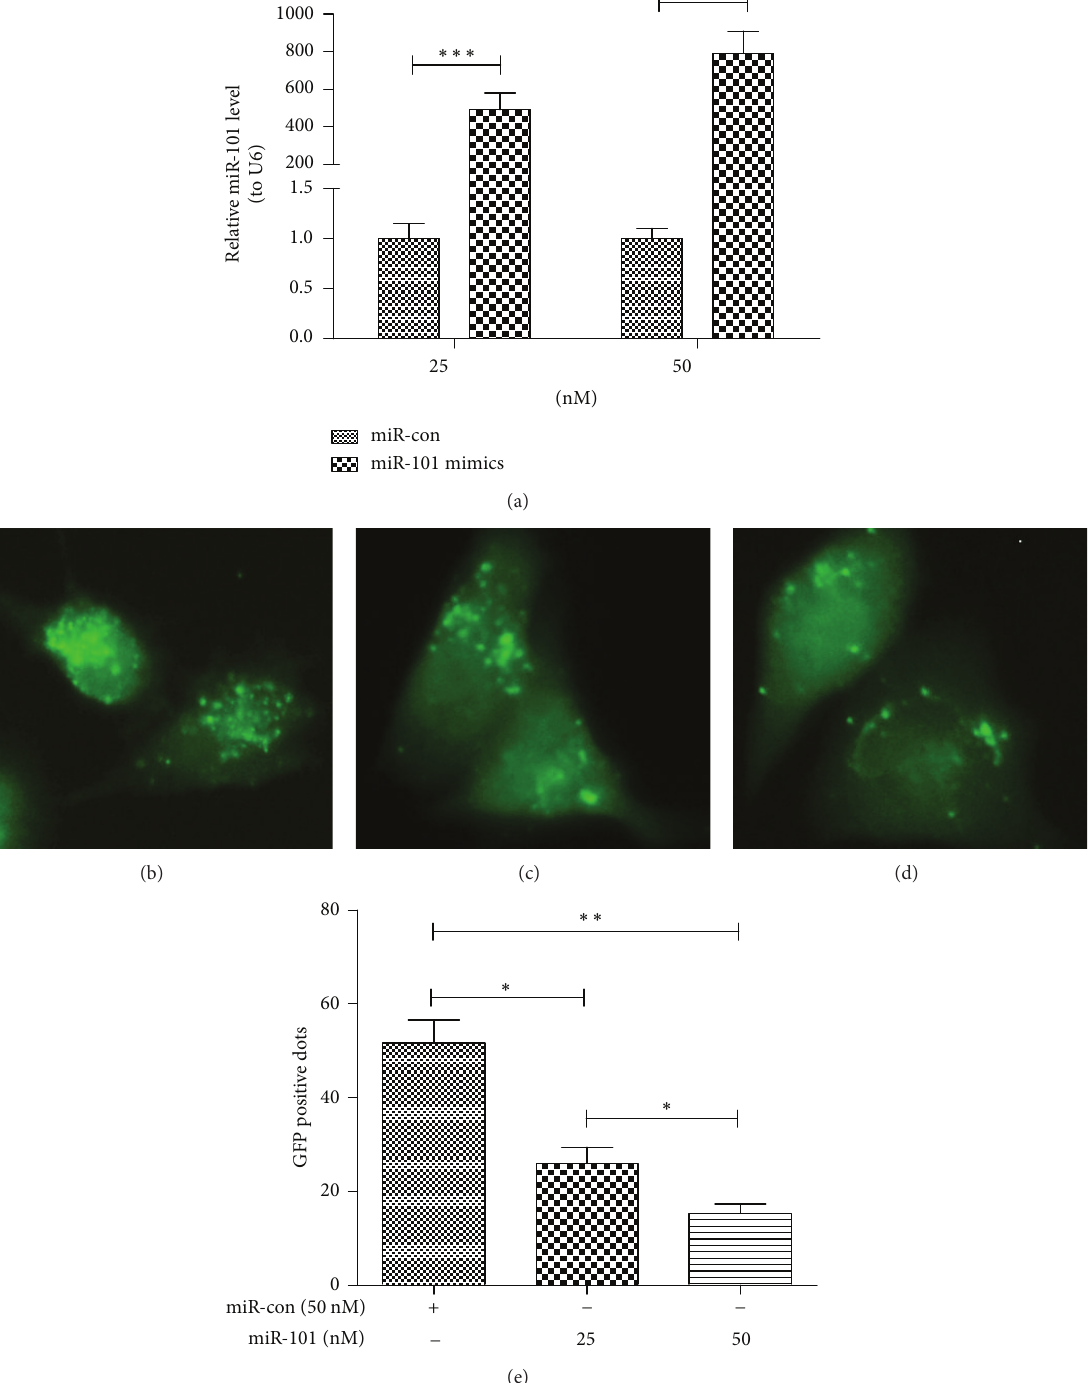
Figure 3: MiR-101 inhibits the Dox-promoted autophagic vesicles formation in U-2 OS cells. (a) MiR-101 mimics’ transfection dramatically elevated the miR-101 level than the transfection of miRNA control. (b) AVOs formed in U-2 OS cells after 50 nM miR control transfection; (c) and (d) AVOs formed in U-2 OS cells after 25 (c) or 50 nM (d) miR-101 mimics transfection. (e) Quantitative analysis of GFP-positive dots (AVOs) in U-2 OS cells. ( ∗ 𝑃 < 0.05 , ∗∗ 𝑃 < 0.01 ). All experiments were independently performed at least for three